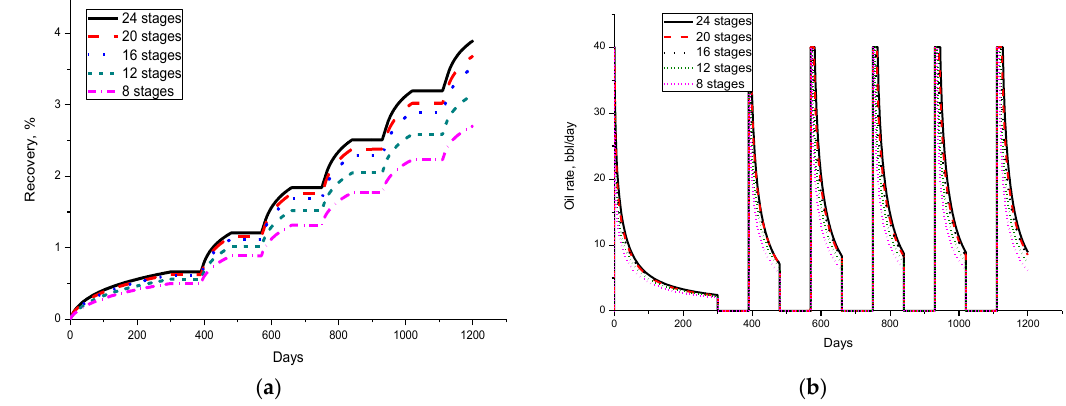
Figure 13. Simulation results for different hydraulic fracture stages. ( a ) Recovery of different hydraulic fracture stages; ( b ) Oil rate of different hydraulic fracture stages.